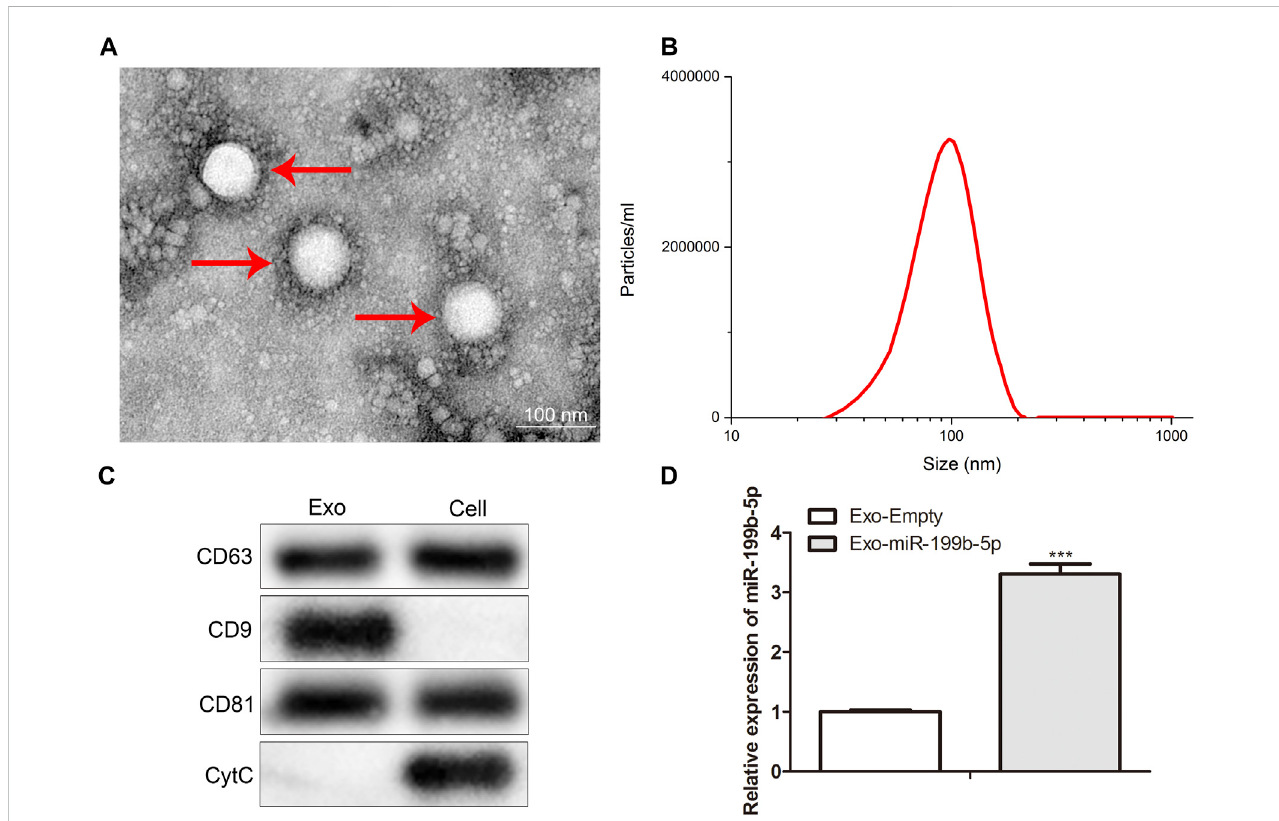
FIGURE 1 iPSCs-Exo was successfully isolated. (A) TEM displayed the morphology of iPSCs-Exo. (B) NTA revealed the concentration particles of iPSCs-Exo. (C) Western blot assay detected the protein levels of CD63, CD9, CD81 and CytC. (D) RT-qPCR detected the miR-199b-5p expression in isolated exosomes. *** p < .001 vs. the